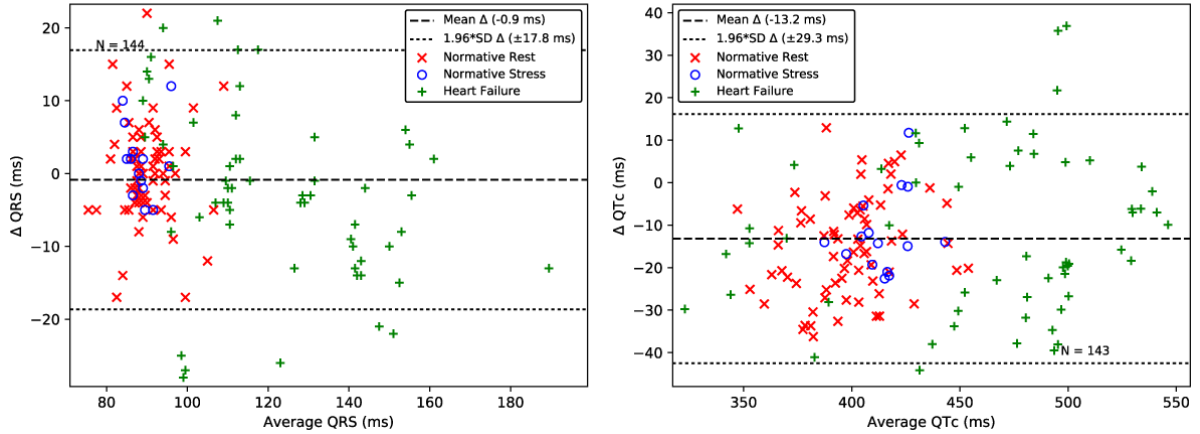
Figure 9. QRS duration (left) and QTc interval (right) extracted from the bECG signal for normative rest (red x), normative poststress (blue o), and heart failure (green +) are closely aligned with those extracted from the gold-standard Lead II ECG. The dashed line shows the mean error. The dotted lines show 1.96 times the SD, corresponding to a 95% limits of agreement. bECG: buttocks electrocardiogram; ECG: electrocardiogram; QTc: corrected